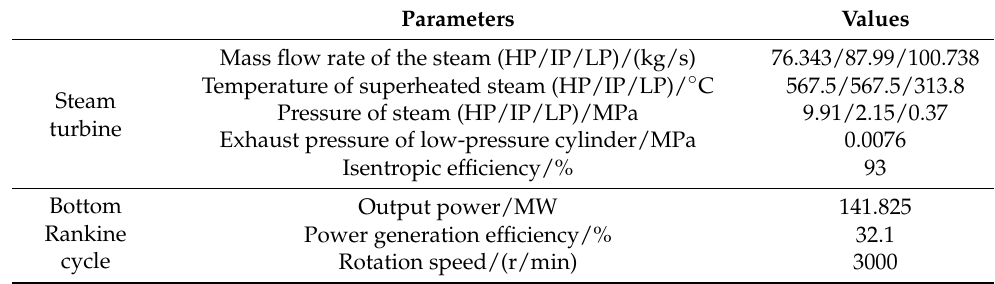
Table 3. Design parameters of steam turbine.